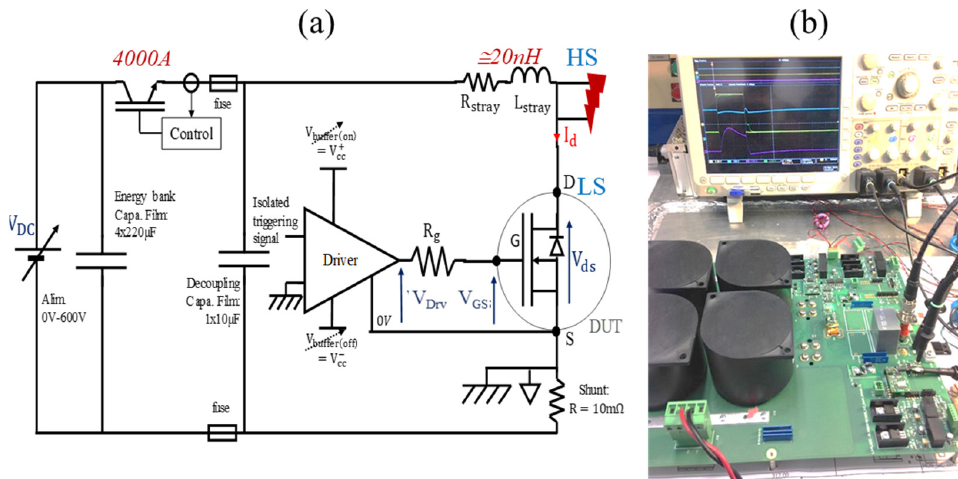
Figure 1. ( a ) Schematic view of the power test bench used for short-circuit test. ( b ) V1-2018 Laplace Laboratory test-bench: Max 600 V, 400 A, 100 µs, 125 °C.